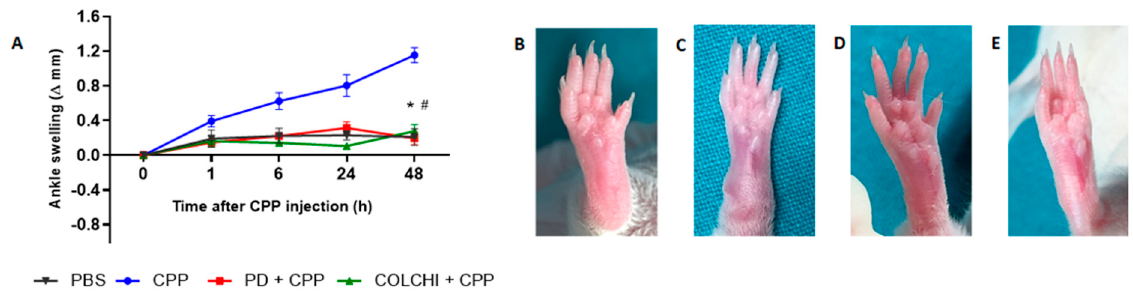
Figure 2. Variation in ankle swelling after CPP crystal injection and drug treatment in the prophylactic group. ( A ) Mice received PD (40 mg/kg) or colchicine (1 g/kg) treatment before the i.a. injection of CPP crystals (0.3 mg/20 μ L) (n = 8/group). Analysis of variance by Kruskal–Wallis test for CPP group, p = 0.0025. Mann–Whitney test CPP group vs PD + CPP group and colchicine + CPP at 48 h, * p < 0.01; CPP group vs colchicine + CPP at 48 h, # p < 0.01. Delta swelling at each time point has been calculated with respect to the basal point. ( B – E ) Pictures depict ankles at the endpoint of the study (48 h): ( B ) PBS injection; ( C ) CPP injection; ( D ) CPP and prophylactic treatment with PD; ( E ) CPP and prophylactic treatment with colchicine.